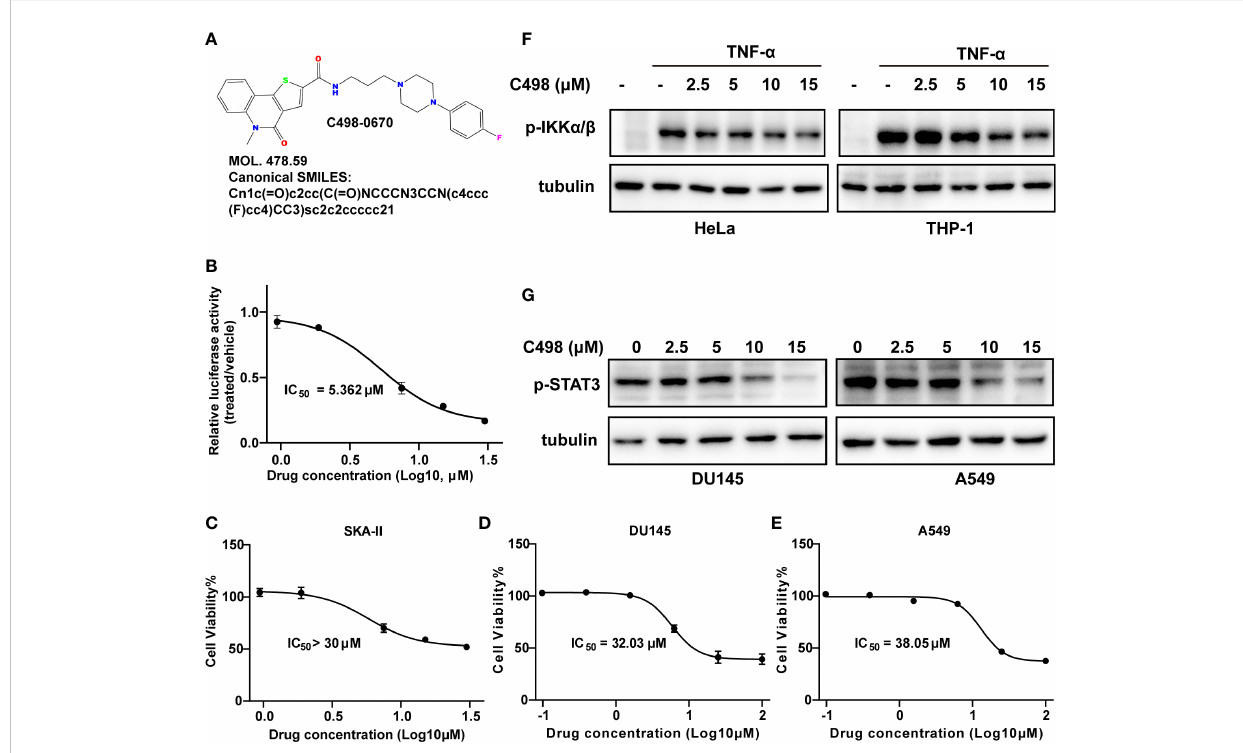
FIGURE 1 C498 is identi fi ed as a dual-target inhibitor of STAT and NF k B signaling pathways by a luciferase drug screening system. (A) , The chemical structure, molecular weight, and Canonical SMILES of C498. B-E, SKA-II, DU145 and A549 cells were seeded in 96-well plates and cultured overnight. Cells were treated with DMSO or a serial of C498 for 24 h. Luciferase activities of SKA-II cells were determined after 24 h (B) . The cell viability of SKA-II (C) , DU145 (D) and A549 (E) cells was determined after 24 h using resazurin assay. (F) HeLa and THP-1 cells were treated with DMSO or C498 at 2.5, 5, 10, and 15 m M for 2 h, followed by TNF- a stimulation (20 ng/ml, 10 min). Western blot analysis was determined on whole cell lysates and detected with anti-pSer176/180-IKK a / b antibodies. Tubulin was used as a loading control. (G) A549 and DU145 cells with constitutive STAT3 activation